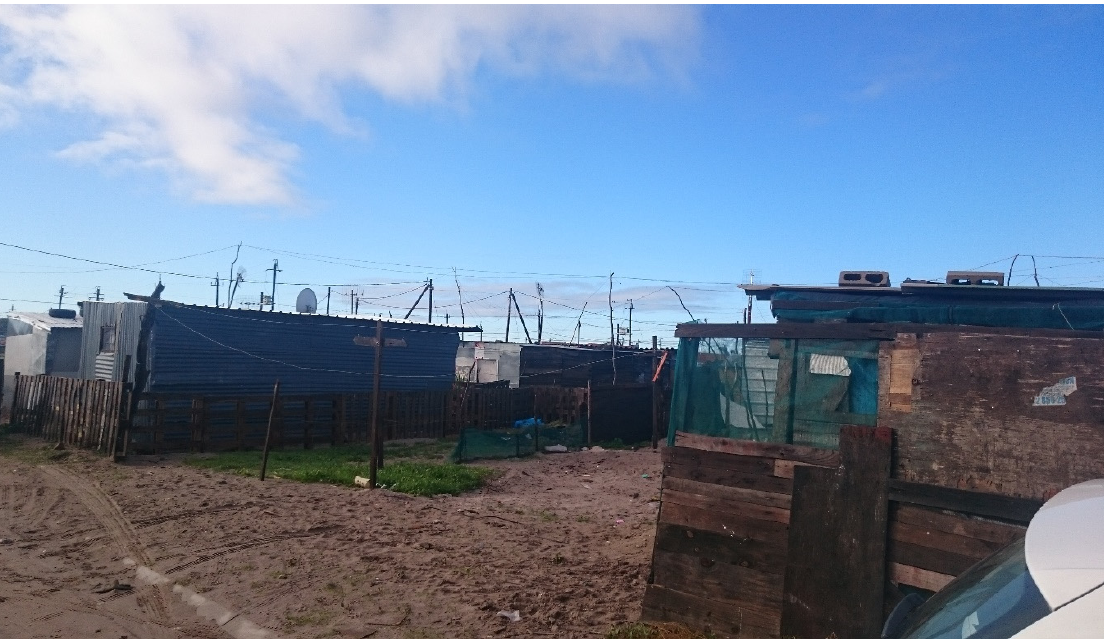
Figure A3. Bokamoso informal settlement in 2015, North West, South Africa.